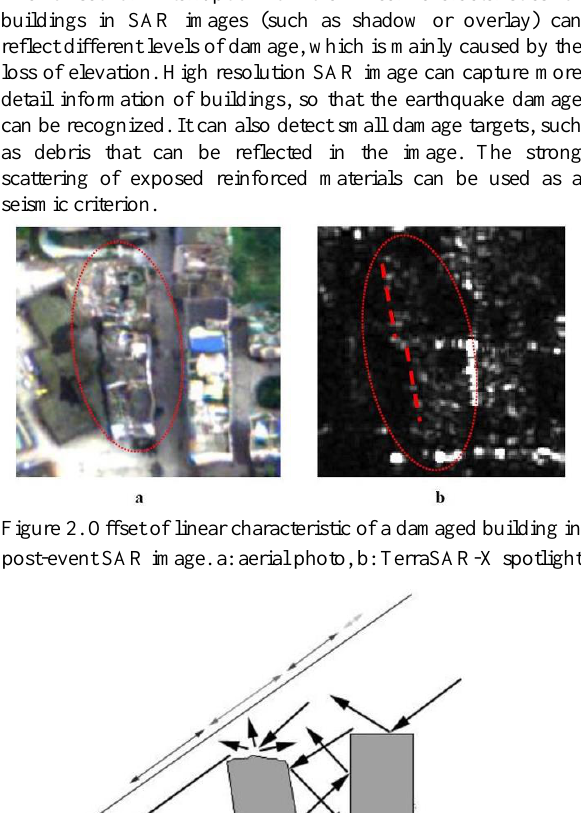
Figure 1. Damaged buildings in different remote sensors. a: aerial photo, b: Cosmo-Skymed SM, c: TerraSAR-X spotlight, d: Cosmo-Skymed SP